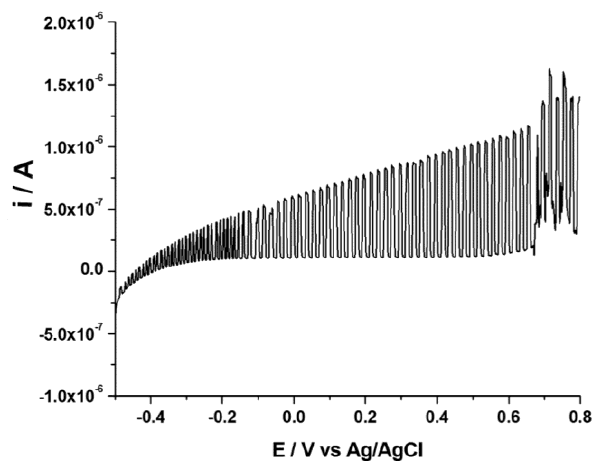
Figure 3. Linear sweep voltammetry recorded in 0.1 M phosphate buffer,·pH 7, 0.1 mM hydrazine under chopped UV light. WE: TiO 2 NWA; RE: Ag/AgCl (KCl saturated; CE: Platinum Coil, scanrate 5 mV·s −1